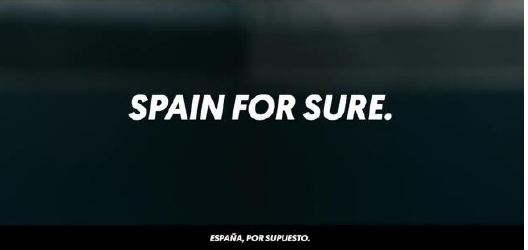
Figure 6. Capture of the “Spain For Sure” campaign (“Spain, of course”) .